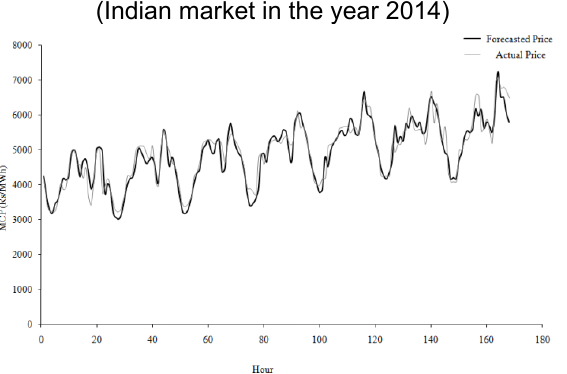
Figure 2 . Forecasted MCP for a week in June (Indian market in the year 2014)